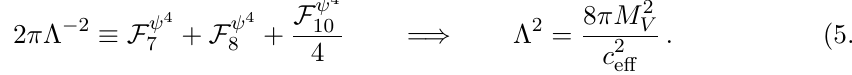
JHEP05(2019)092 ; c bound ) obtained in the various HVT- V e(cid:11) = 4 : 15 TeV [86]. V